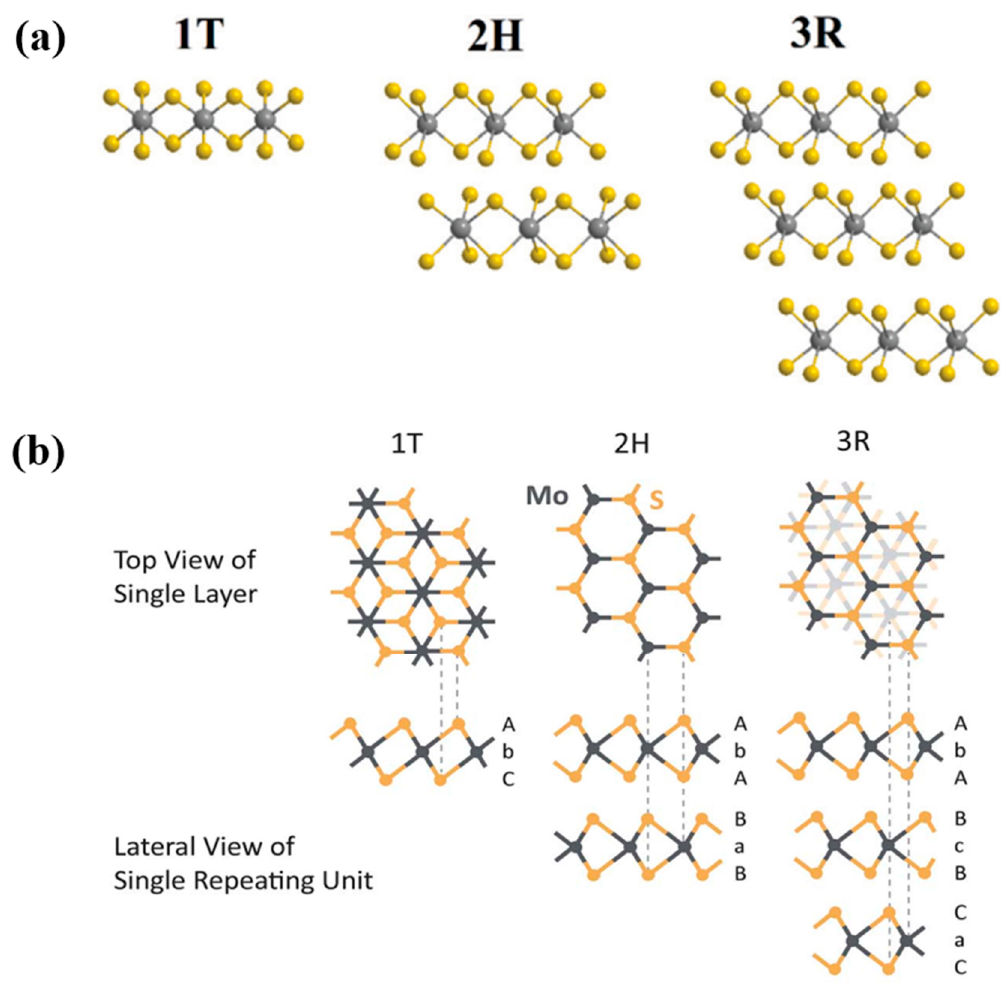
Figure 3. ( a ) Polytype structure of TMDs (1T, 2H, and 3R). Reprinted with permission from Coogan et al. [61] Copyright 2021, Royal Society of Chemistry. ( b ) Polytype structure of MoS 2 . Reprinted with permission from Song et al. [62] Copyright 2015, Royal Society of Chemistry.